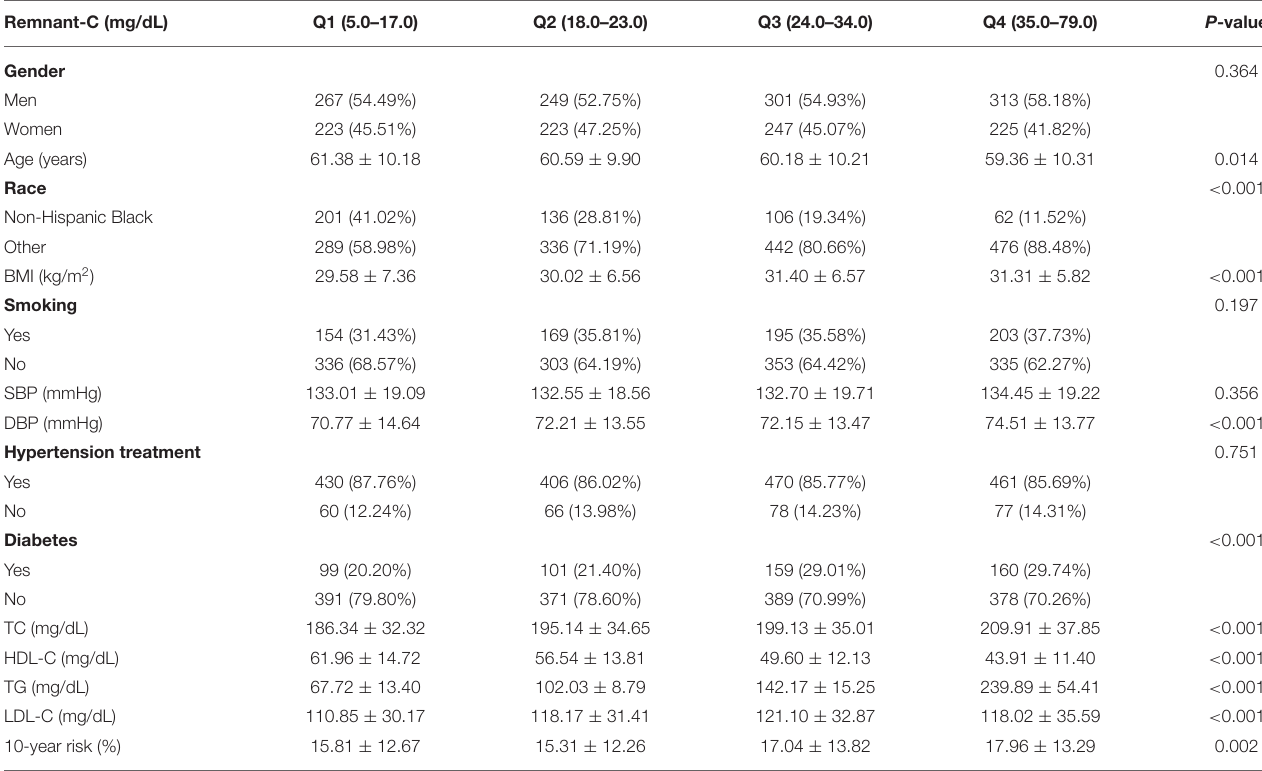
TABLE 1 | Baseline characteristic of participants.